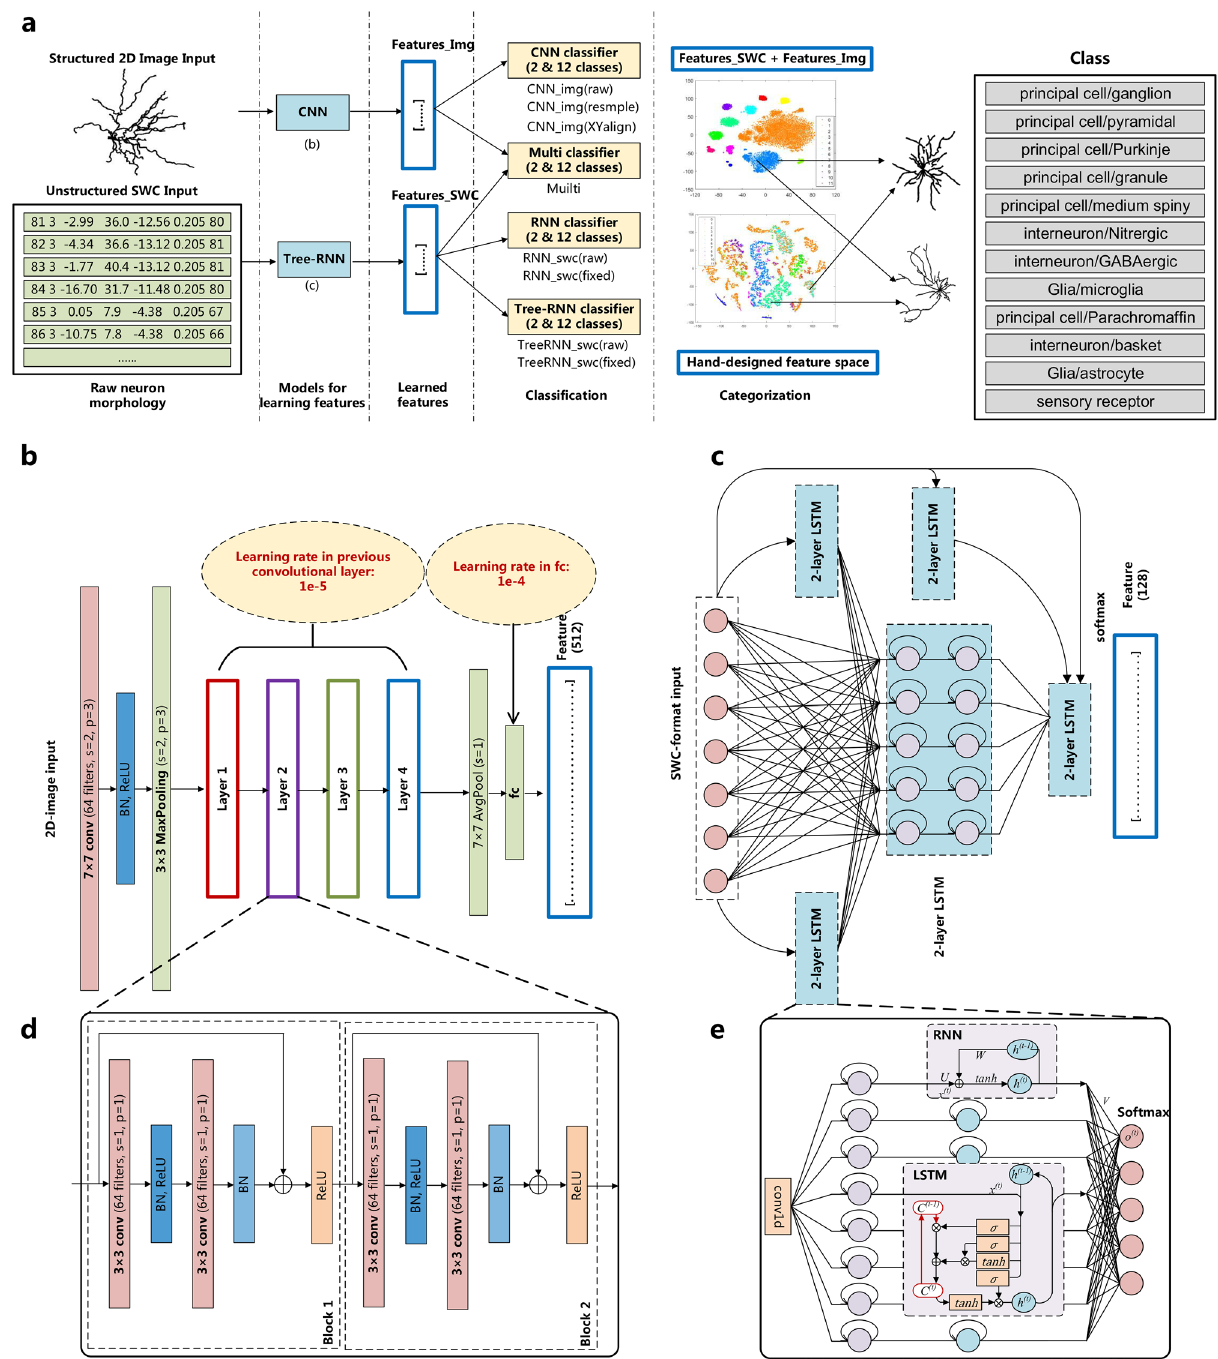
Figure 6. The proposed integrated DNN architecture contains a ResNet CNN for 2D-image feature detection and Tree-RNN for SWC-format feature detection. ( a ) Diagram of the processing procedure, including the data preparation, feature learning, neuron classification, and categorization. ( b ) The structure of ResNet18 for image classification. The input is three-channel images from the projections of the X, Y, and Z axes. Before the residual blocks, data are first processed by convolution, batch normalization (BN), ReLU activation, and MaxPooling. The following four layers have different residual block hyperparameters, as shown in Table 2. The output is the generated features after completing average-pooling and full-connection. ( c ) The proposed Tree-RNN, including the standard structures of the RNN and LSTM modules. There are five 2-layer LSTM blocks in this tree, and black arrows represent the connections between them. Every block has the same structure, which contains two hidden layers, each with 128 neurons. Finally, the result is output through a fully connected layer. The dotted boxes show the basic operating units of the RNN and LSTM. ( d ) The submodule of the ResNet layer. ( e ) The submodule of the Tree-RNN, which can also be considered the traditional simple 2-layer